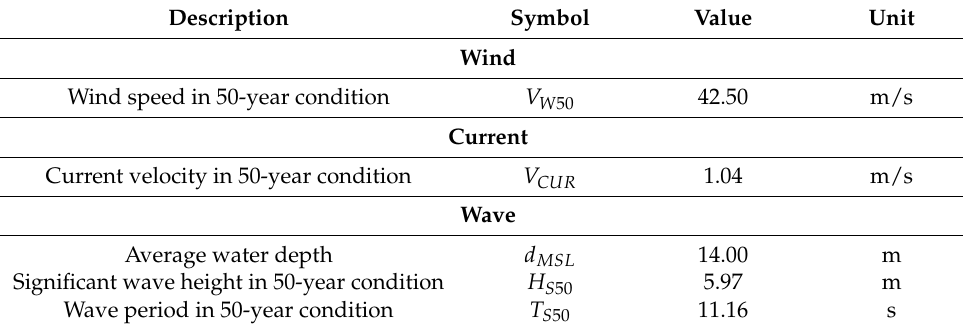
Table 2. Extreme environmental conditions at the reference site [16].